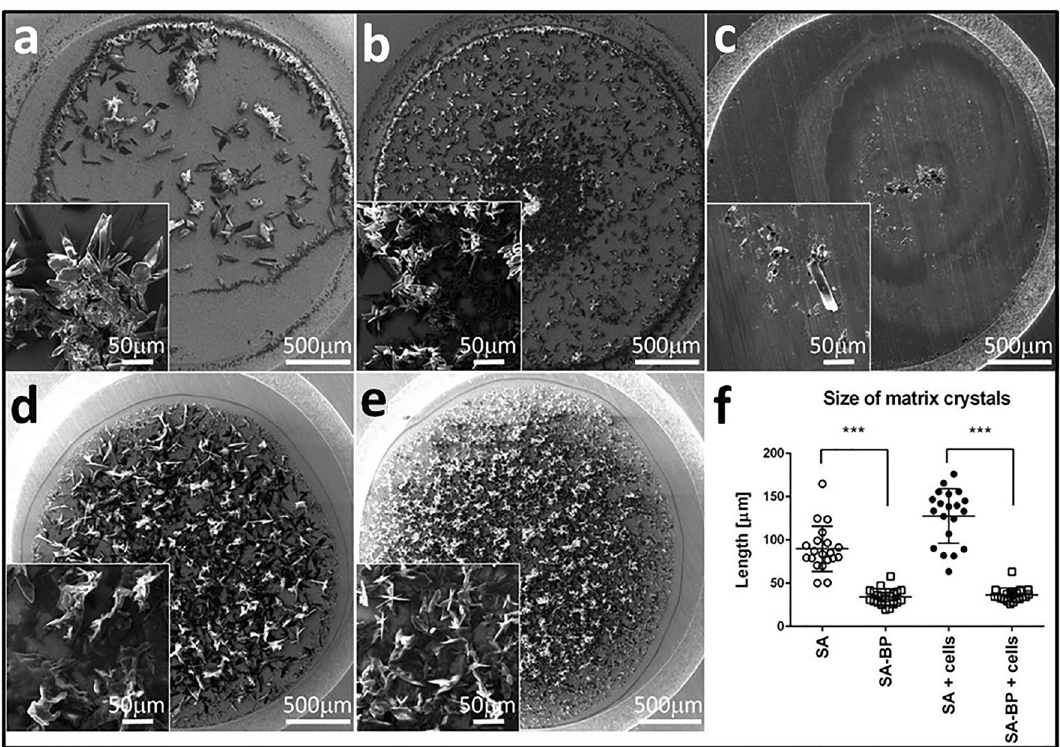
Figure 2. Black phosphorus improves sinapinic matrix crystallization as visualized by scanning electron microscopy (SEM). SA matrix either alone or enriched by BP was mixed with cells washed in 1× phosphate- buffered saline and resuspended in 150 mM ammonium bicarbonate buffer, spotted in the steel MALDI plate, and visualized by SEM. ( a ) SA only, ( b ) SA enriched by BP (SA-BP), ( c ) BP suspension only, ( d ) SA + hESC cell line CCTL L14, ( e ) SA-BP + hESC cell line CCTL L14, and ( f ) size distribution of matrix crystals ( n = 20).